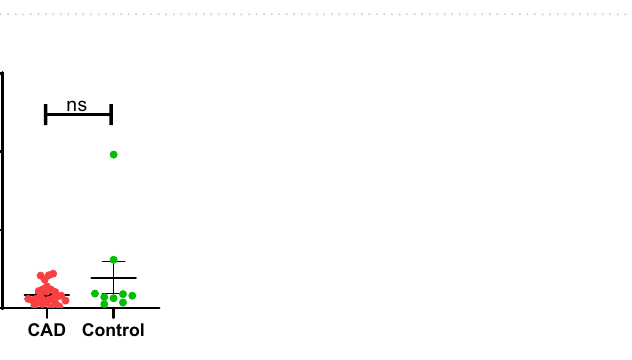
Figure 1. Intracellular ECFC’s Biopterin levels in CAD patients and controls. ECFC’s BH4 (Tetrahydrobiopterin), BH2 (Dihydrobiopterin), BH4/BH2 ratio in CAD (n = 27) and healthy control groups(n = 09). ( A ) ECFC’s BH4 in picomol/mg protein ( B ) ECFC’s BH2 in picomol/mg protein ( C ) BH4/BH2 ratio. Significance difference between the group was assessed by student t-test. Data is represented as mean ± SE. Error bar represent standard error of mean; dots represent average values of the parameters obtained from experimental duplicates; p ≤ 0.05 considered statistically significant.